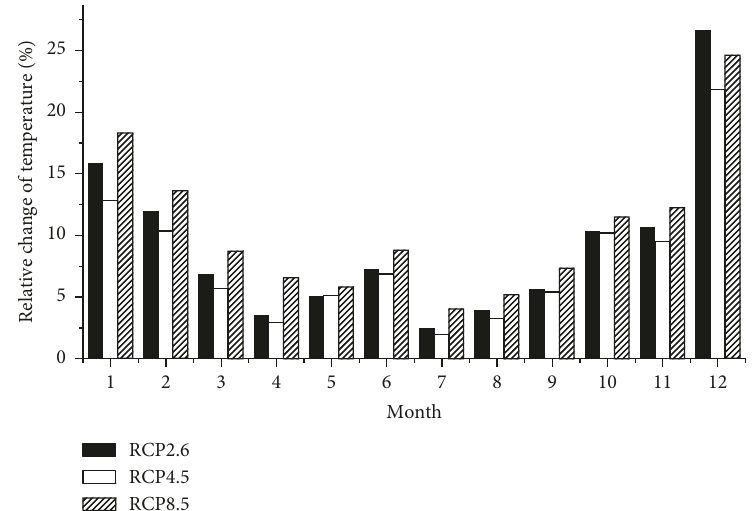
Figure 10: Relative changes of monthly average temperature between 2019–2050 and 1961–2018.